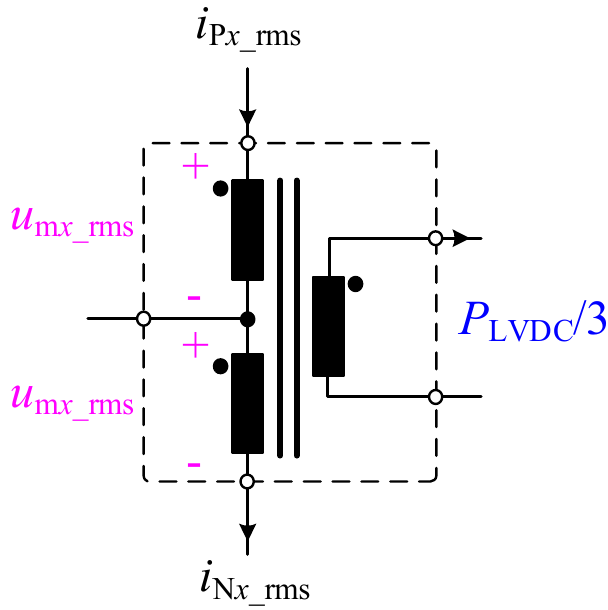
Figure 12. The processed power of each winding of integrated transformer.